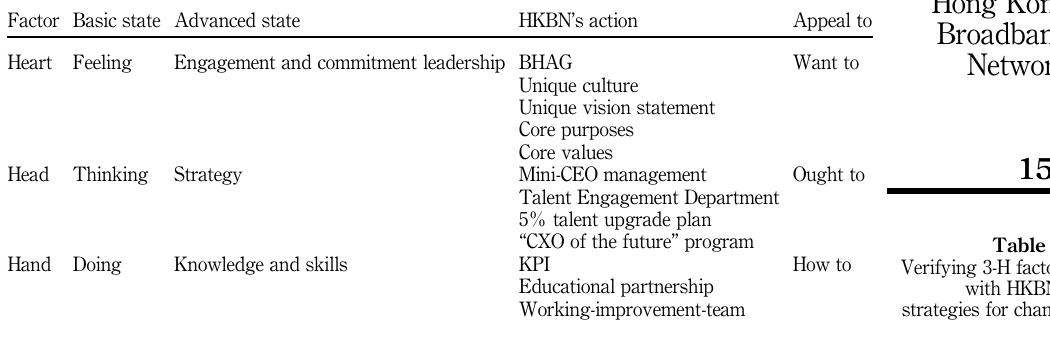
Table II. Verifying 3-H